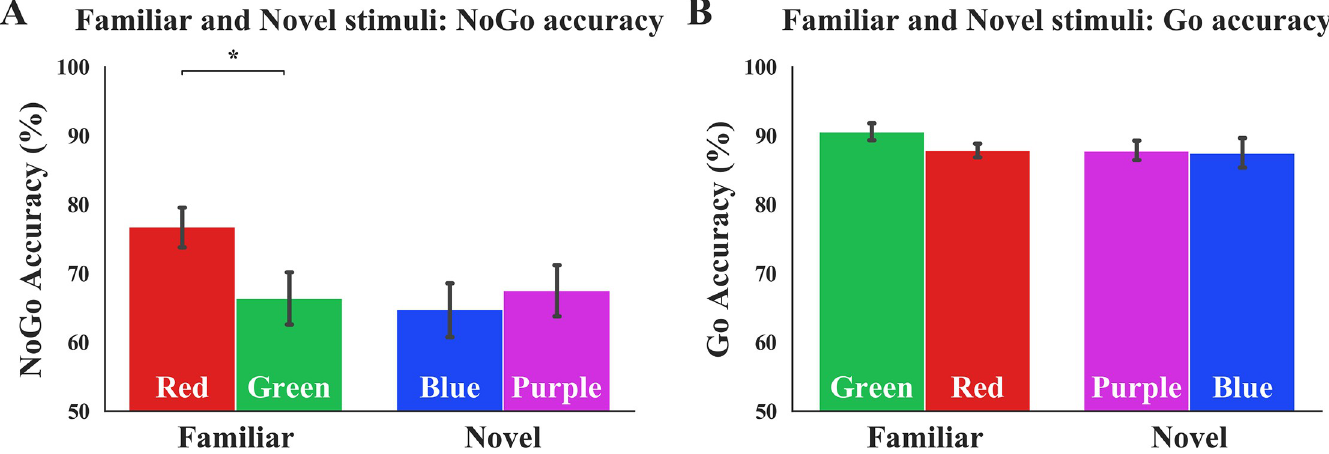
Fig 2. NoGo and Go performance to familiar and novel stimuli. (A) . Familiar stimuli elicit mapping-related change in NoGo accuracy. Participants make significantly fewer errors of commission when the NoGo signal is red compared to green. There is no difference in accuracy in the Novel condition when the NoGo signal is purple vs. blue. Stim_Familiarity x Color–Response_Mapping interaction: p = .004. (B) Familiar stimuli do not significantly elicit mapping-related change in Go accuracy. There is no significant difference in Go accuracy when Go signal is red compared to green. Likewise, no differences are seen in the Novel condition, when Go signal is blue vs. purple. Stim_Familiarity x Color–Response_Mapping interaction: p = .140. Error bars depict standard error of mean (SEM). Color of bars reflects NoGo and Go stimulus colors.